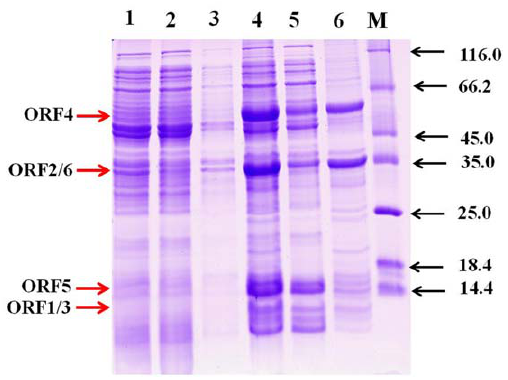
Figure 1. SDS-PAGE analysis of protein samples of PH_ IND from E.coli BL21 (DE3). Line 1. Whole cells of pET-28a( + ); Line 2. Cell extracts of pET-28a( + ); Line 3. Precipitation of pET-28a( + ); Line 4. Whole cells of strain PH_ IND ; Line 5. Cell extracts of strain PH_ IND ; Line 6. Precipitation of strain PH_ IND ; M. Protein markers. Arrows show the positions of the six ORFs. ORF1. 10.4 kDa; ORF2 . 37.6 kDa; ORF3. 10.5 kDa; ORF4. 59.2 kDa; ORF5. 13.5 kDa; ORF6. 38.6 kDa. SDS-PAGE was performed with 5% and 15% acrylamide concentrations for